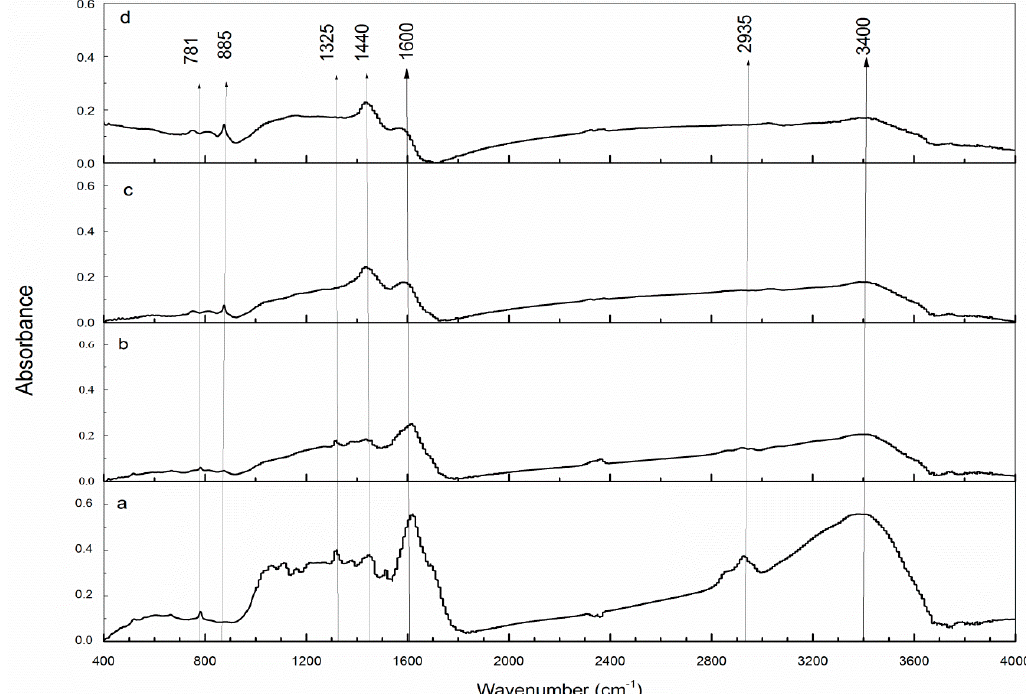
Figure 4. Fourier-transform infrared (FTIR) spectra peaks of biochars produced at: ( a ) 300 °C; ( b ) 400 °C; ( c ) 500 °C; and ( d ) 600 °C, respectively.